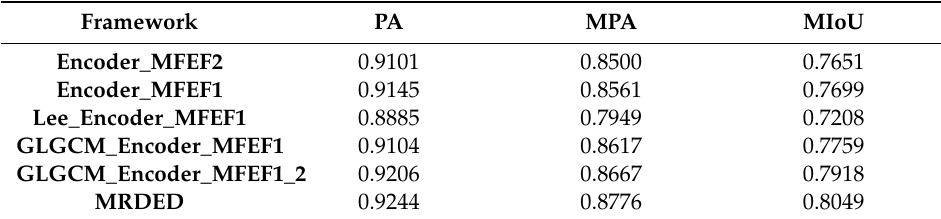
Table 3. The classification accuracy of the first set of